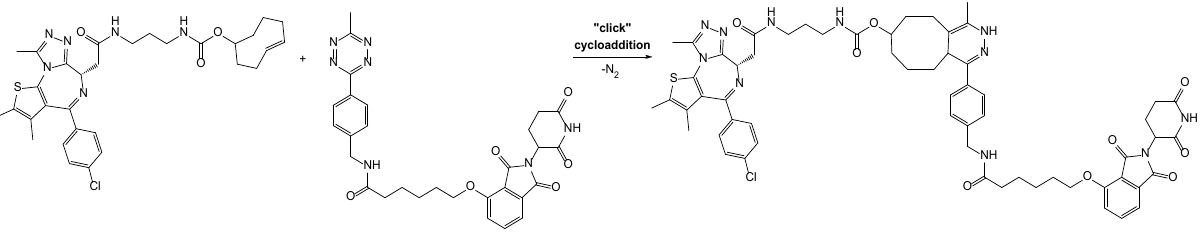
Figure 2. Representative scheme explaining the self-assembly of in-cell click-formed PROTACs